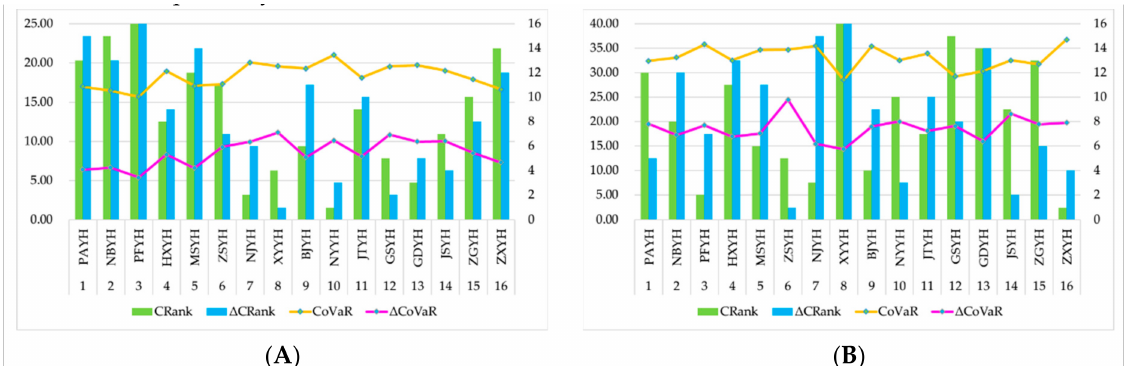
Figure 5. The results of CoVaR and ∆ CoVaR (In the figure, the CoVaR refers to the Conditional Value at Risk when a bank is in distress; ∆ CoVaR refers to the di ff erence between the CoVaRs when the bank is in distress and in a normal state): ( A ) 2017; ( B ) 2018.